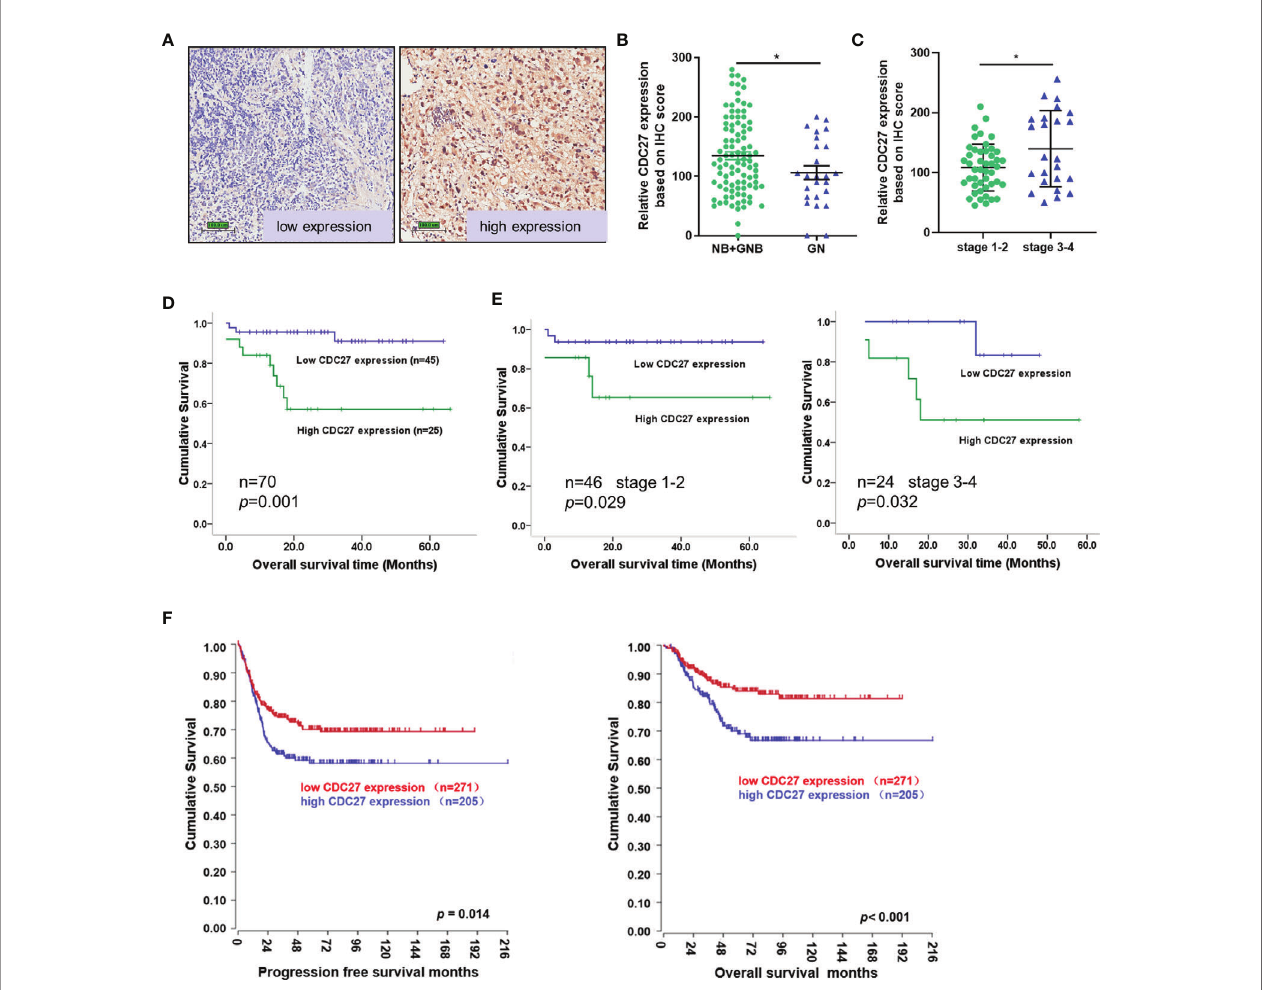
FIGURE 1 | CDC27 predicted poor prognosis of NB patients. (A – C) Representative images of CDC27 expression detected by IHC in NB tissues; each point in the graph represents the CDC27 expression H-score of an individual patient tumor. *p < 0.05 based on Student ’ s t test. (D, E) Kaplan – Meier survival analysis of OS according to CDC27 expression evaluated by IHC in 70 collected NB patient tissues. (F) Kaplan – Meier survival analysis of the association between CDC27 expression and PFS or OS according to the Gene Expression Omnibus (GEO)